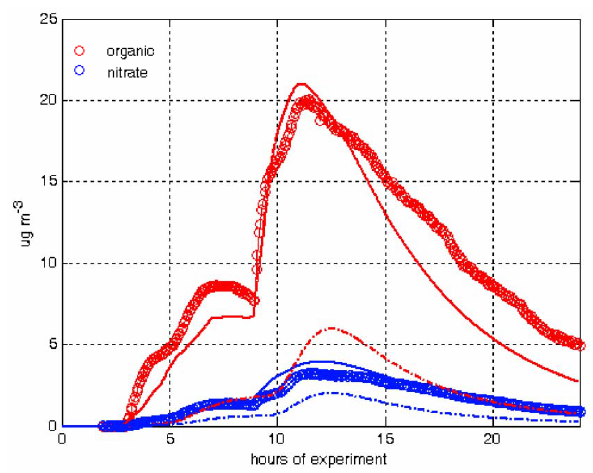
Fig. 5. Change in measurement/model agreement of AMS-measured aerosol organic and aerosol nitrate mass loading before (dashed lines) and after (solid) tuning predicted vapor pressures. mass onto which organic nitrates can partition. 5.2 Interpreting nitrate and aerosol formation after second limonene injection